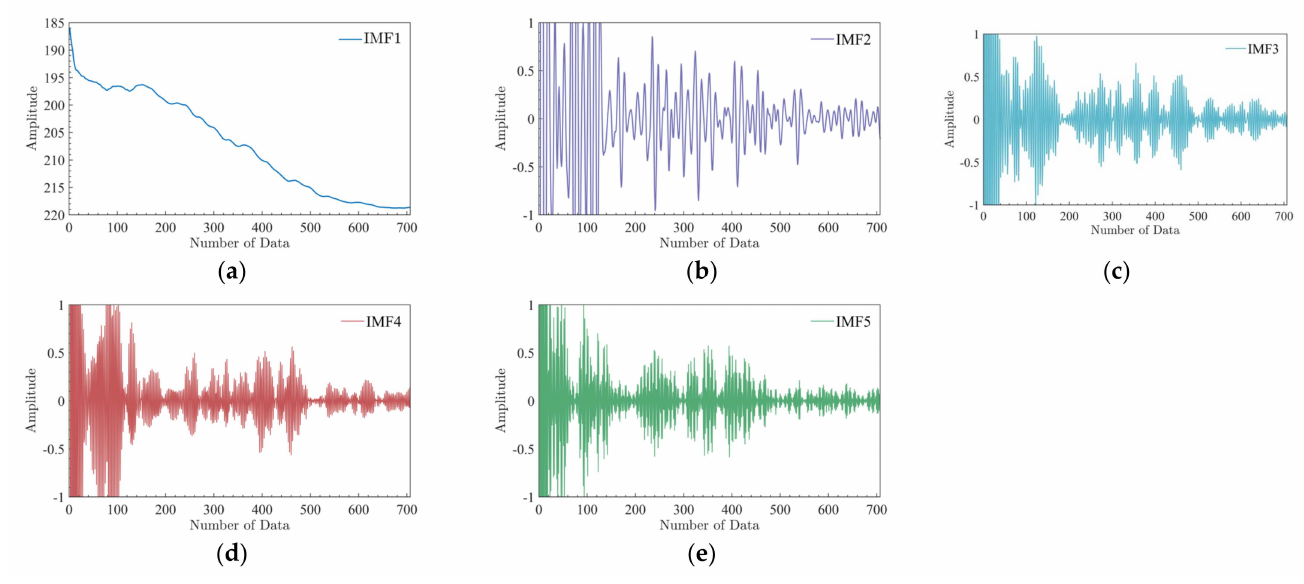
Figure 8. IMF components of PL sequence for the first set:( a ) IMF1; ( b ) IMF2; ( c ) IMF3; ( d ) IMF4; ( e ) IMF5.